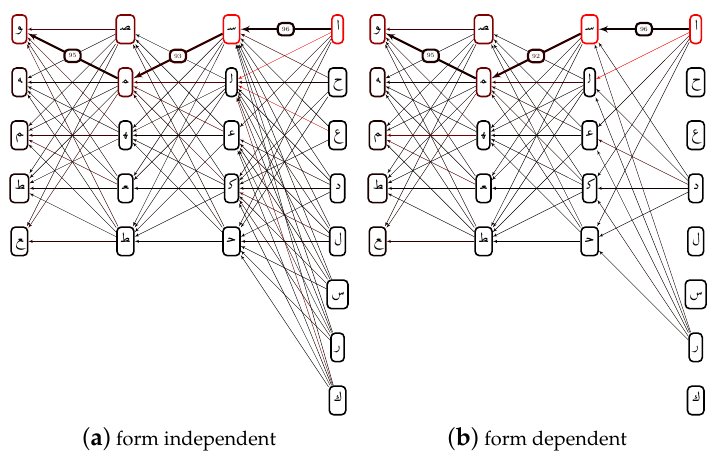
Figure 8. Error correction using a priori knowledge on character level. An error could be detected, since, according to the vocabulary , no (cid:144) can follows after (cid:128) . Feature based rankings go top V 50k down and are indicated by the node color, a priori by the edge color (dark high ∼